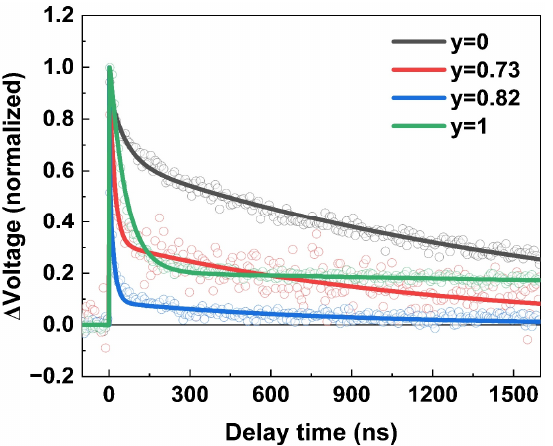
Figure 4. TRMC kinetics of MAPb(Br 1 − y I y ) 3 SCs with indicated I compositions. The solid lines are fitting curves based on multi-exponential decay functions, and the detailed fitting parameters are shown in Table 2.